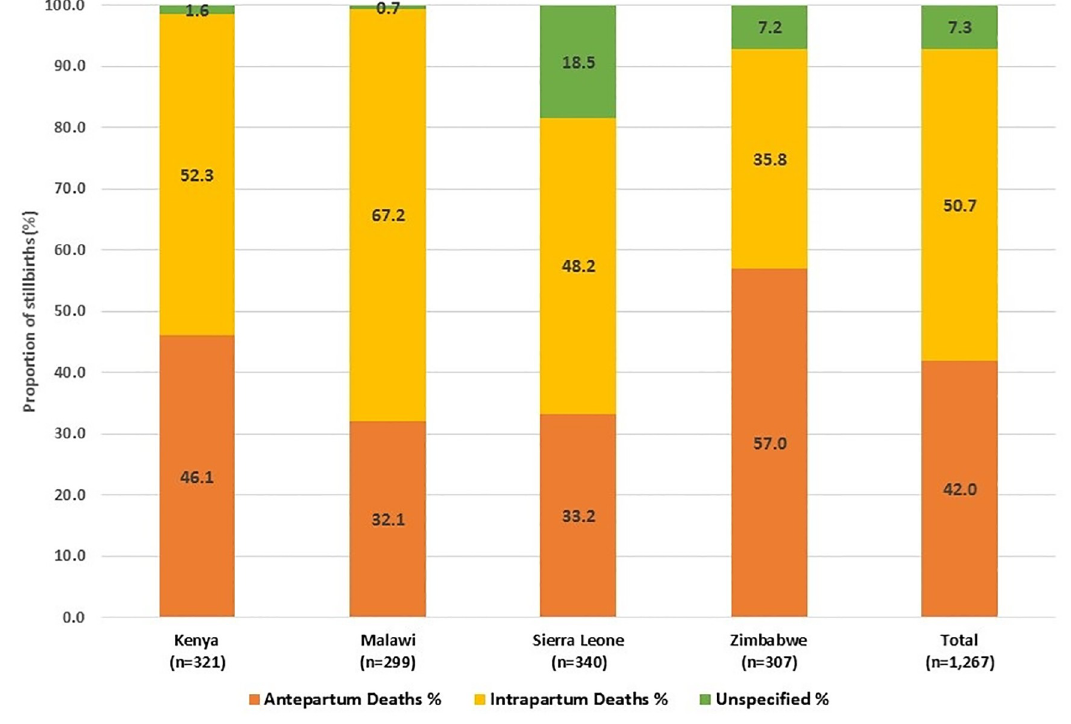
Fig 1. Distribution of stillbirths by timing of